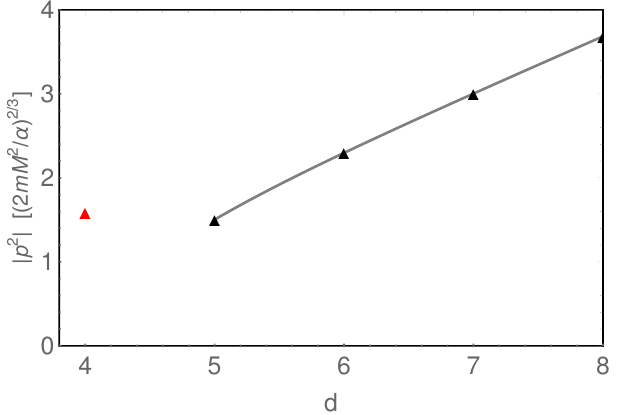
Figure 5 . The modulus of p 2 for the pole positions of the S -wave in the AC model is shown as a function of d and in units of (2 mM 2 /α ) 2 / 3